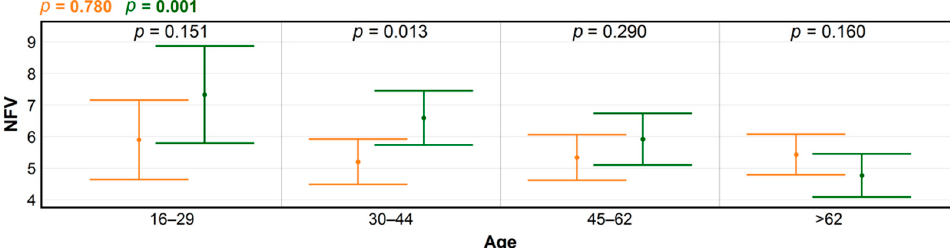
Figure 7. Levels of significance for differences in numbers of forest visits (NFV) according to age, before (orange) and during the COVID-19 pandemic (green), produced using ANOVA; and for within-group NFV differences (black), determined by t -test.